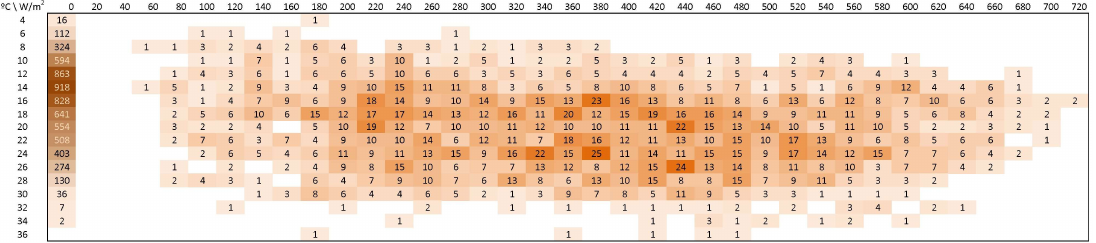
Figure 8. Frequency matrix for CT in Almeria: modified DNI-temperature.